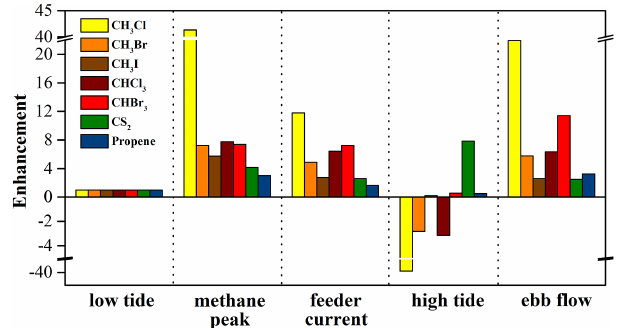
Figure 4. Relative enhancement of selected VOC fluxes from a tidally influenced seagrass bed. All fluxes were normalized to the respective mean fluxes during low tide. Mean and ranges are pro- vided in Table